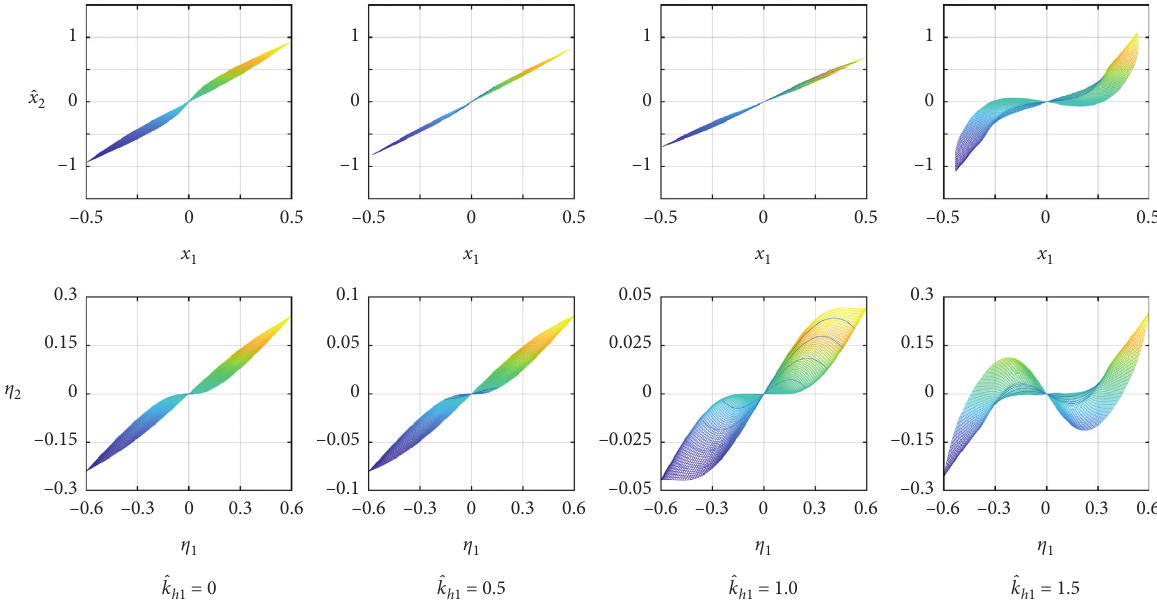
Figure 11: Top plots: the NNM invariant manifold approximations and five representative periodic motions in the phase space of physical coordinates ( 􏽢 x proximations and periodic motions in the phase space of modal coordinates ( η